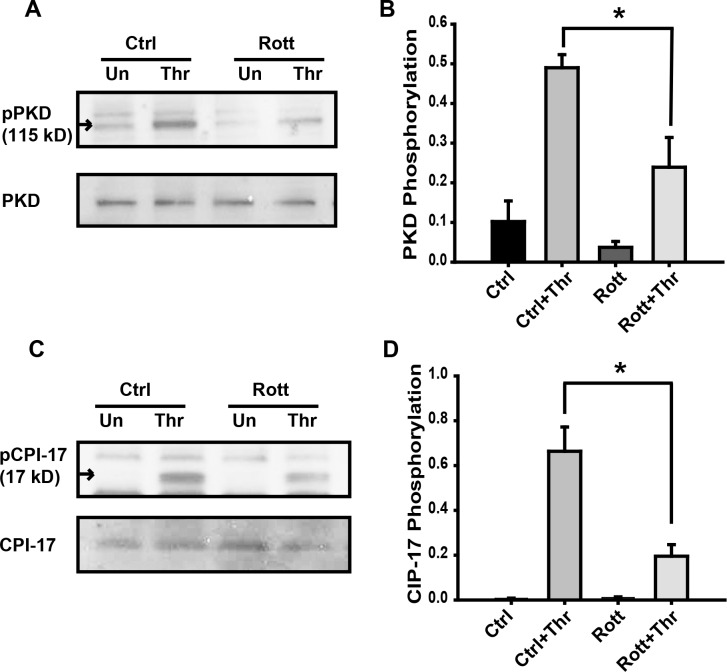
Effect of rottlerin pretreatment on thrombin-induced PKD and CPI-17 phosphorylation.(A) EC were pretreated with rottlerin (10 μM, 30 min) followed by stimulation with thrombin (1U/ml, 5 min) and whole cell lysates were immunoblotted with anti-phospho-PKD and anti-PKD antibody. Unstimulated cells (Un) were used as controls. (B) Normalized densitometry analysis of PKD phosphorylation is shown (n ≥ 3/condition, * p < 0.05). (C) In subsequent experiments using the same conditions, whole cell lysates were immunoblotted with anti-phospho-CPI-17 and anti-CPI-17 antibody. (D) Normalized densitometry of CPI-17 phosphorylation is shown. n ≥ 3/condition, * p < 0.05.